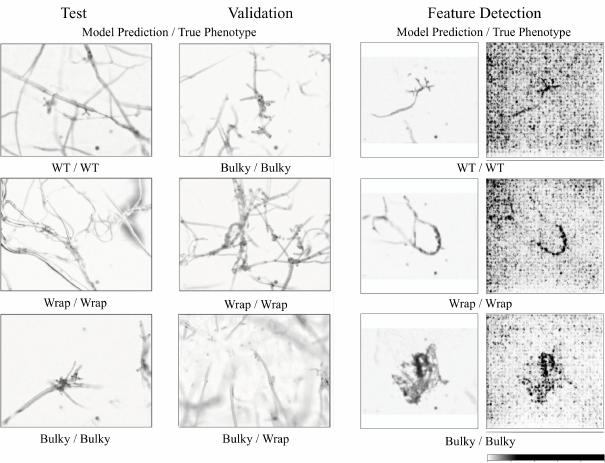
Figure 5. Automatic classification of phenotypes. Model performance on test and validation sets is depicted in the first two columns. The far-left column shows a selected test set, followed by an example validation set in the second column. The third and fourth columns show feature importance evaluation for a few test samples. The third column shows the original image (after padding and resize) with the last column identifying feature importance. A higher value (black) in the last column indicates greater feature importance. All images are labeled with the model predicted phenotype first and manually identified phenotype